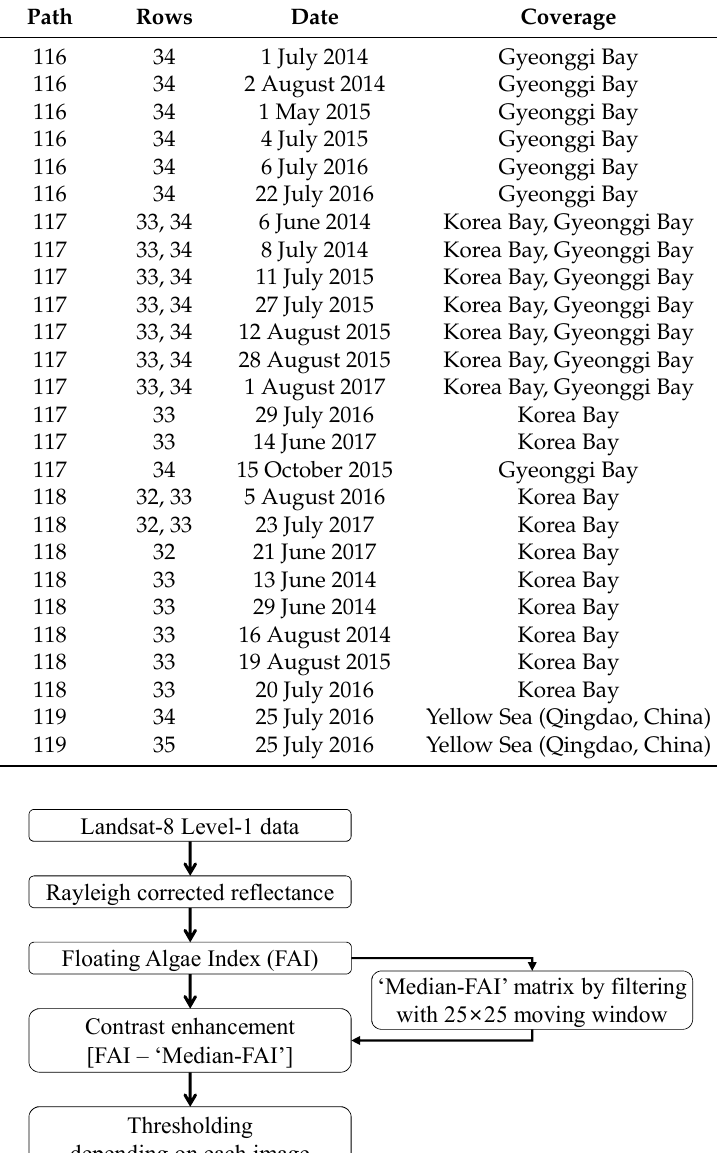
Table 1. List of Landsat-8 images used in this study.